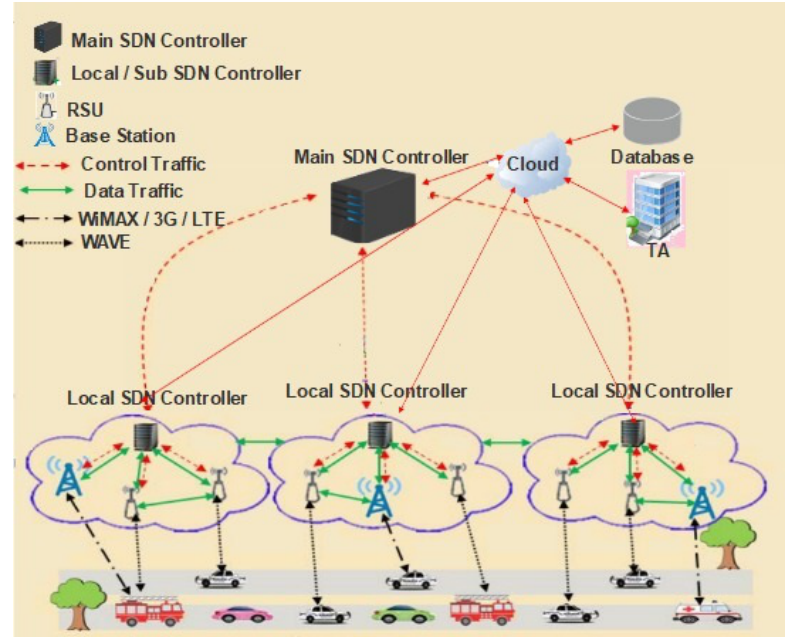
Figure 1. Proposed hierarchic architecture for